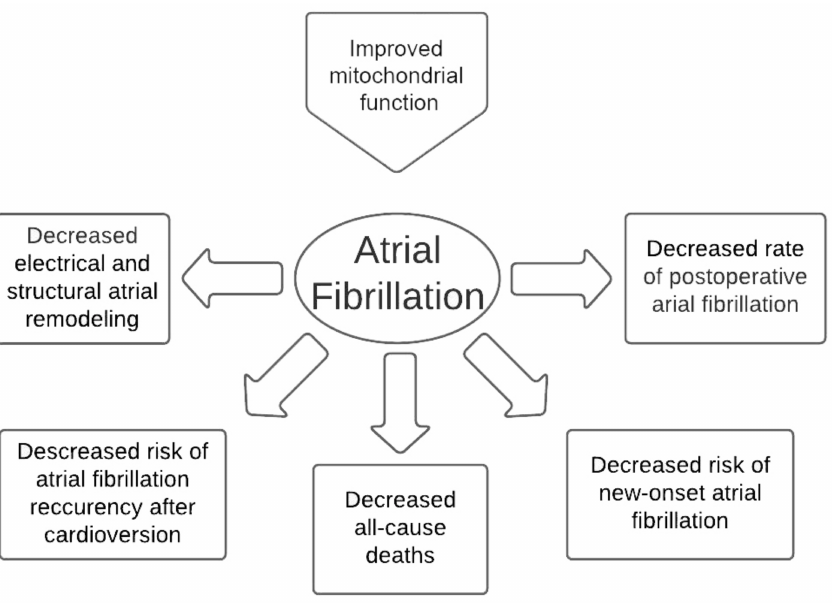
Figure 1. Clinical benefits expected from improvement of the mitochondrial function in atrial